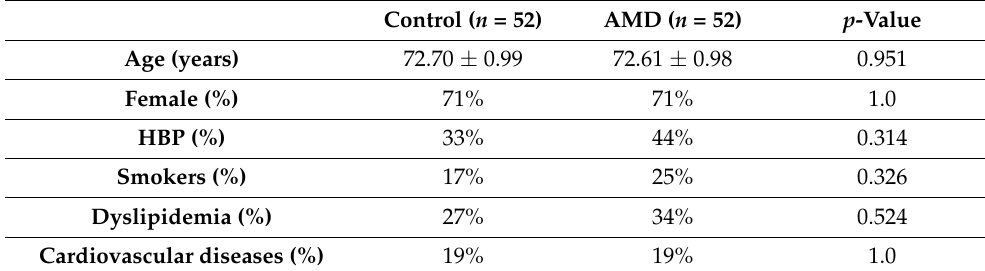
Table 1. Demographic data and clinical characteristics of participants.